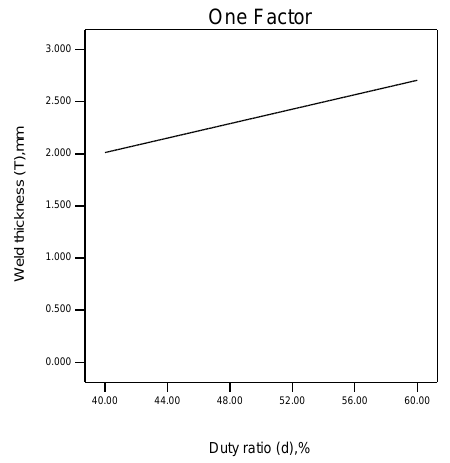
Figure 9. Influence of duty ratio on weld thickness.